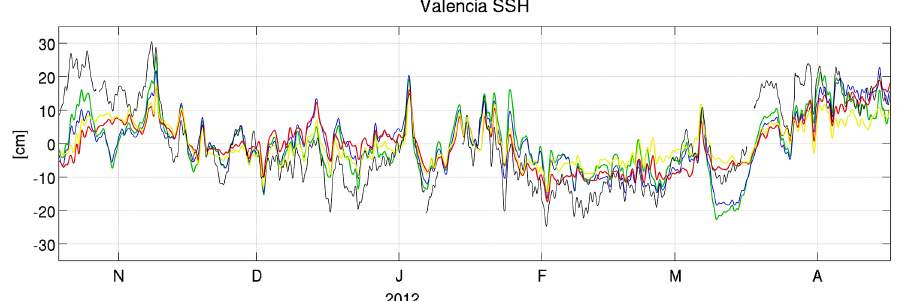
Figure 6. Valencia η time-series from observations and model results. Data and model results have been filtered with 5h running mean. Observations, black; NEMO-MFS1, red; NEMO-MFS2, blue; NEMO-MFS3, yellow; NEMO-MFS4, green.